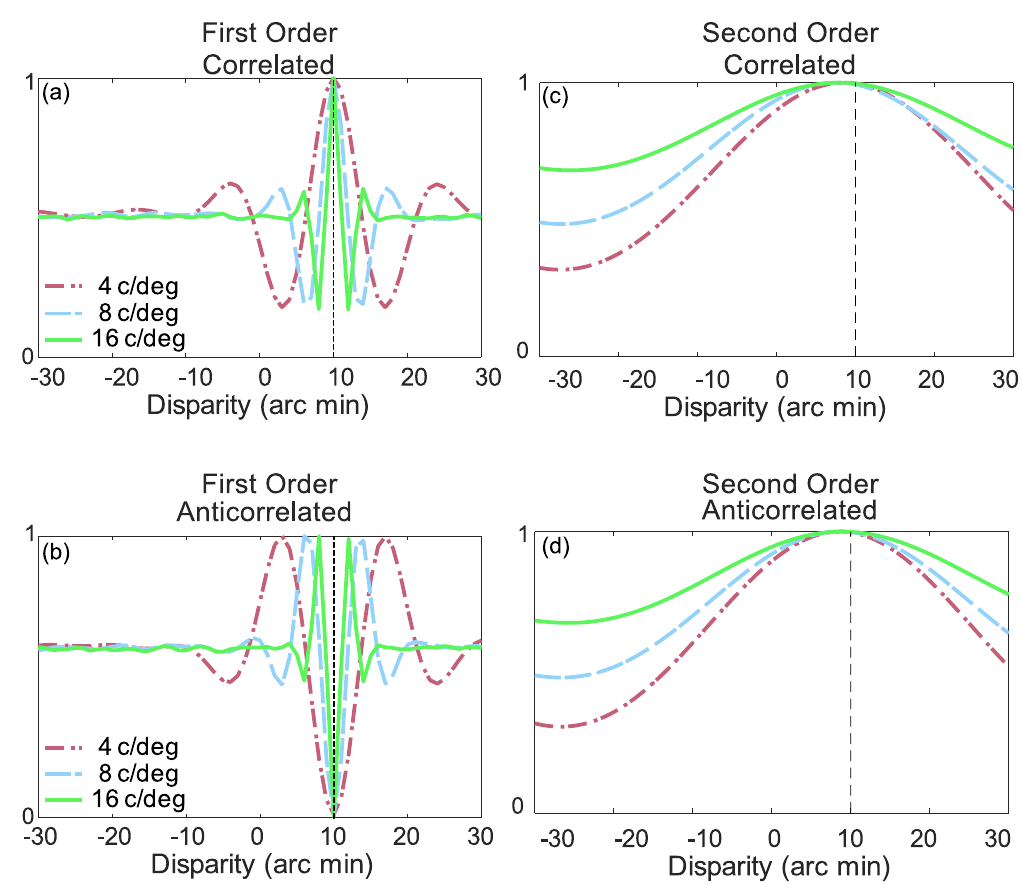
Fig 9. Left: Disparity tuning for first order mechanisms where the spatial frequency tunings of the filters were set to 4, 8 or 16 cycles/degree for (a) CRDS and (b) ACRDS. As predicted by the first order binocular energy response there is a peak at the correct disparity for CRDS (10 arc min), but an inverted peak for the preferred disparity for ACRDS. Right: Disparity tuning for second order mechanisms. Here the mean responses of the second order energy response model show a peak at the correct disparity for (c) CRDS (10 arc min), however for (d) the ACRDS, the inversion of the disparity tuning function is absent. For ACRDS second order models predict depth in the natural direction. Images reproduced with permission [17].